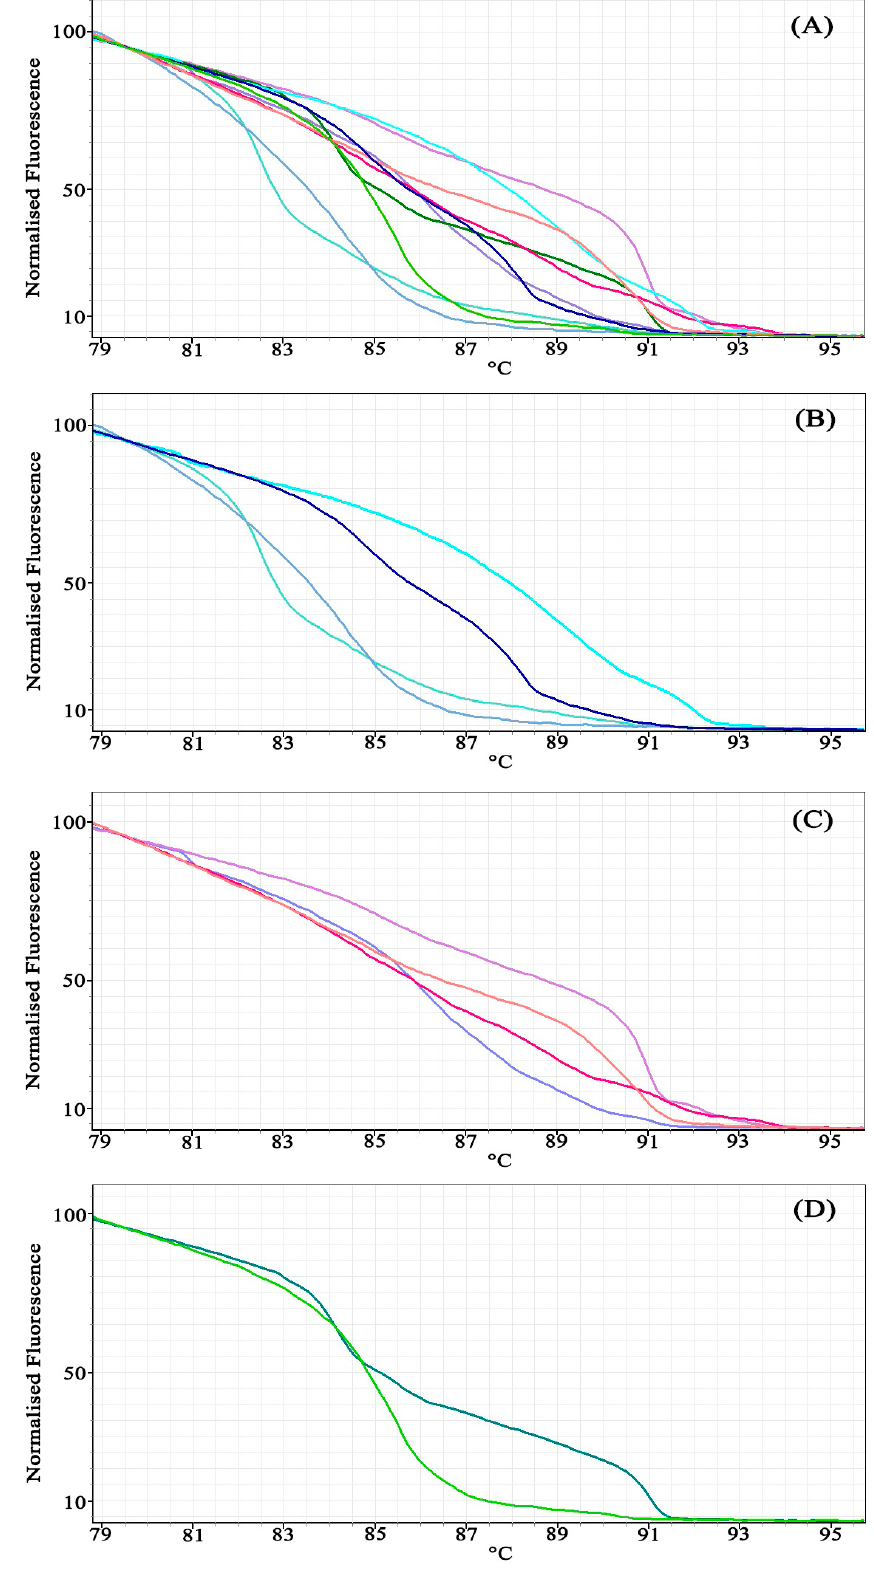
Figure 5. Melting profiles of 10 Dipterocarpaceae species generated from HRM analysis using ITS2 primers. Normalised curves of ( A ) all 10 species; ( B ) species from genus Dipterocarpus ; ( C ) species from genus Shorea ; ( D ) species from genus Hopea .